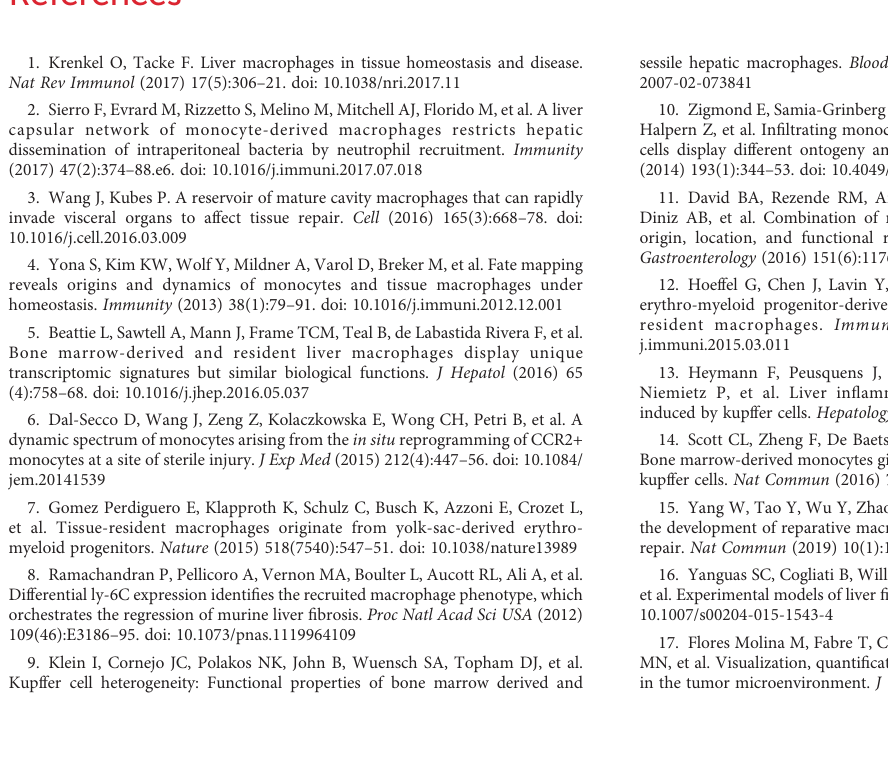
SUPPLEMENTARY TABLE S2 Flowcytometry antibodies and reagents for all other techniques. SUPPLEMENTARY TABLE S3 Sequence of